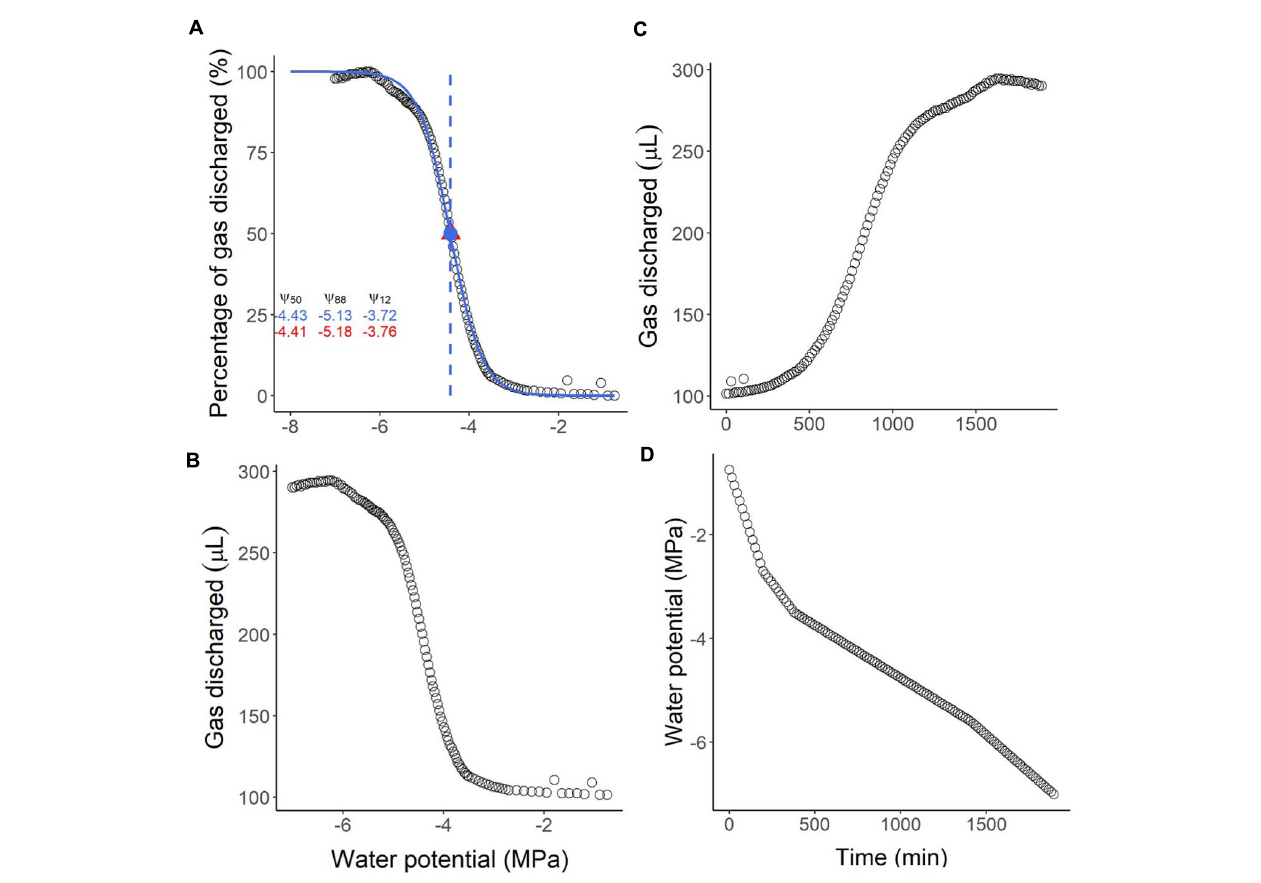
FIGURE 6 | Example of output graphs from the R-script to analyse pneumatic GD volumes measured with a Pneumatron for Olea europea . In (A) the vulnerability curve and the traits estimated from the sigmoidal curve (in blue) are shown. The values in red are the measured values at 12, 50, and 88% PGD (percentage of gas discharged), while the values in blue represent the corresponding estimated values. The water potential corresponding to 50% PGD is shown as the measured (red triangle) and the estimated (blue circle) value. In (B,C) the absolute amount of gas discharged (raw data) is shown as a function of water potential (B) and time (C) . In (D) the estimated water potential for every 15 min is shown as a function of